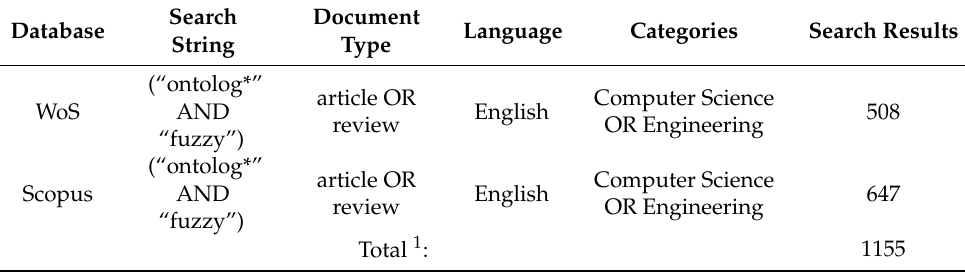
Table 1. Search strings in Web of Science (WoS) and